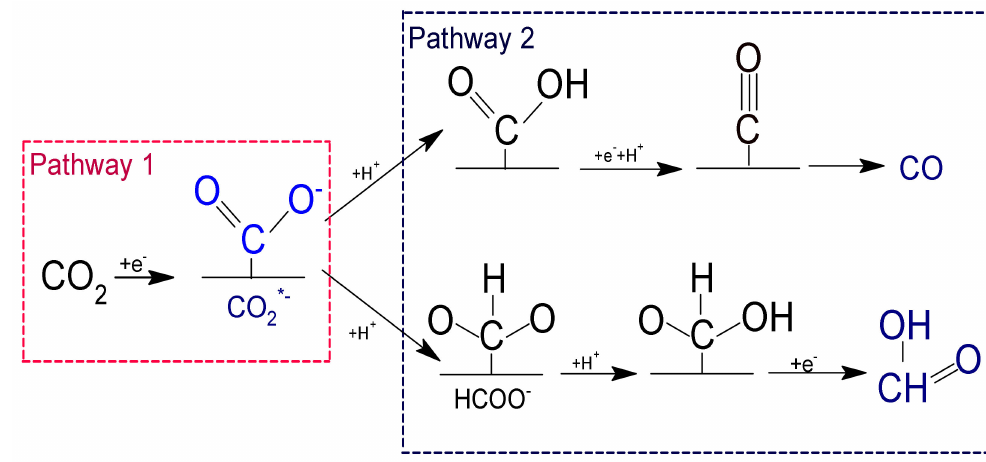
Figure 10. The CO 2 reaction mechanism on BDD.